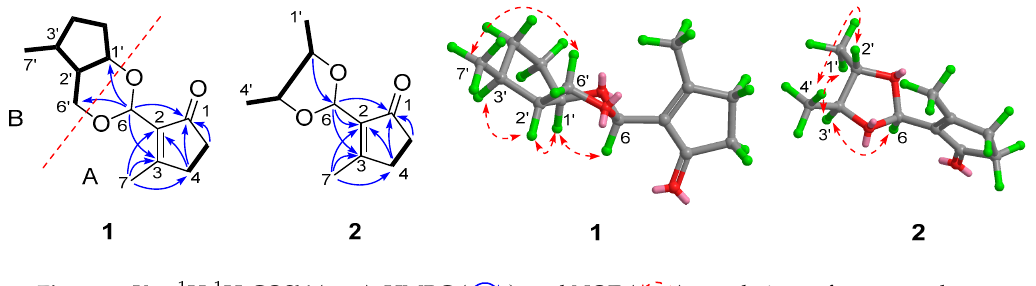
Figure 2. Key 1 H- 1 H-COSY ( ), HMBC ( ), and NOE ( ) correlations of compounds 1 – 2 .